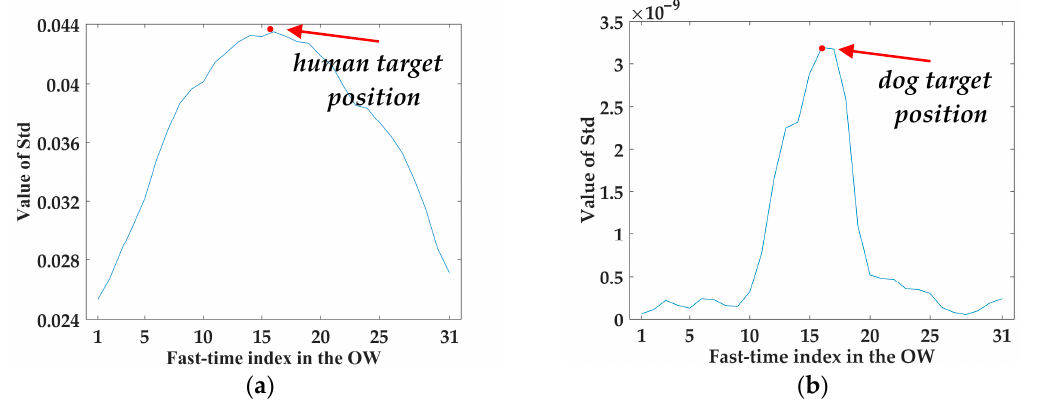
Figure 5. Comparison results of 𝑆𝑡𝑑𝐶𝑅𝑀𝑉 . ( a ) 𝑆𝑡𝑑 of human target; ( b ) 𝑆𝑡𝑑 of dog target.